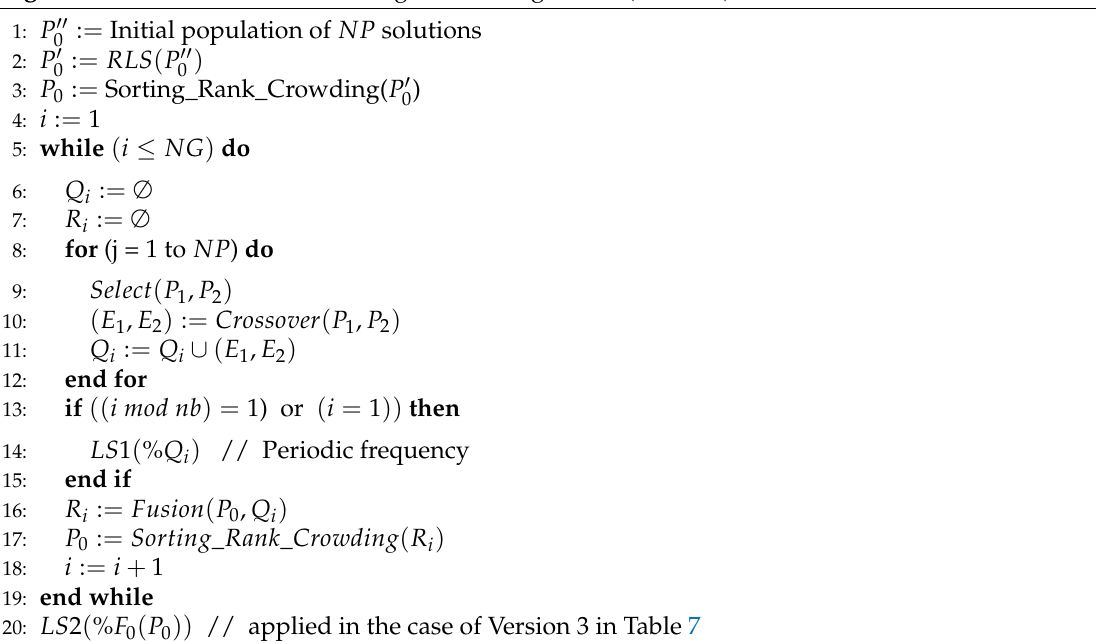
Algorithm 2 Non-Dominated Sorting Genetic Algorithm